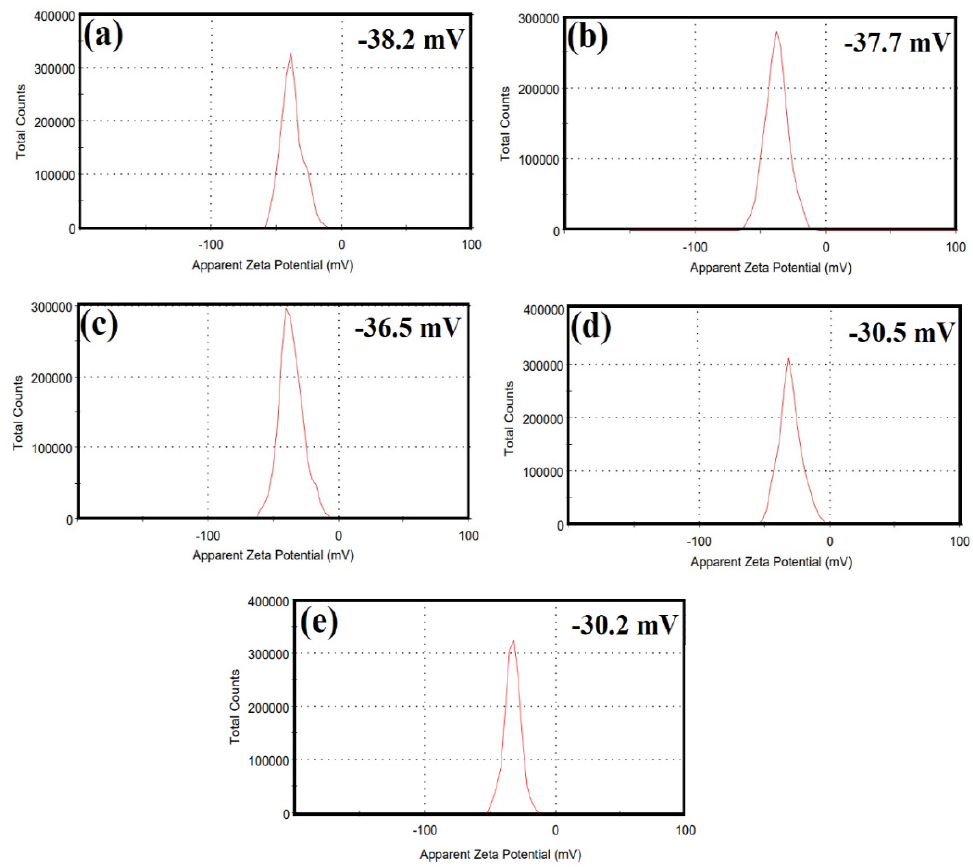
Figure 5. Surface charge determination of ZnCe x Fe 2 − x O 4 by Zeta potential when ( a ) X = 0, ( b ) X = 0.02, ( c ) X = 0.04, ( d ), X = 0.06, and ( e ) X = 0.08 at pH 7 (cultural media pH). Dynamic light scattering (DLS) analysis was performed to evaluate particle size distribution and to calculate the average particle size of the synthesised ZnCe x Fe 2 − x O 4 (X = 0.0, 0.02, 0.04, 0.06, 0.08) NPs that was found as 36.71 nm when X = 0. Additionally, the particle size was found to be 43.20, 45.91, 49.27, and 54.87 nm when X = 0.02, 0.04, 0.06, and 0.08, respectively, in the synthesised ZnCe x Fe 2 − x O 4 NPs, as shown in Figure 6.